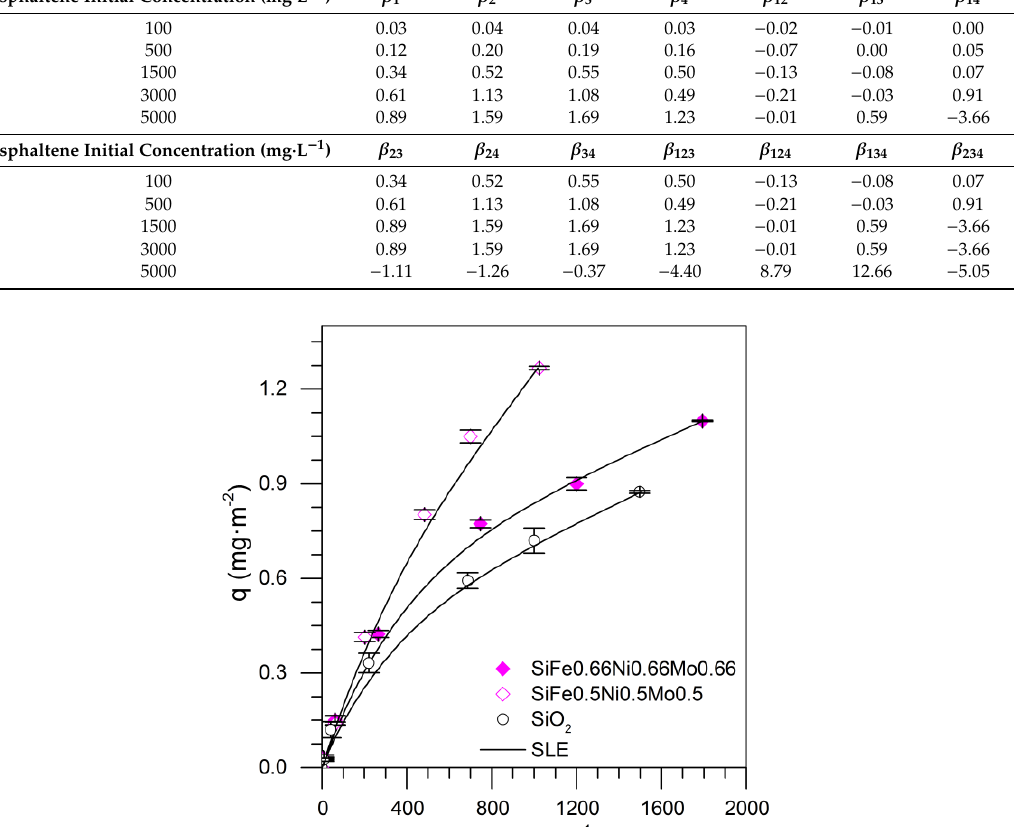
Figure 14. Asphaltene adsorption isotherms for nanoparticles SiO 2 , SiFe0.5Ni0.5Mo0.5, and SiFe0.66Ni0.66Mo0.66 at 25 °C. The symbols are experimental data, and the solid lines are from the SLE model.